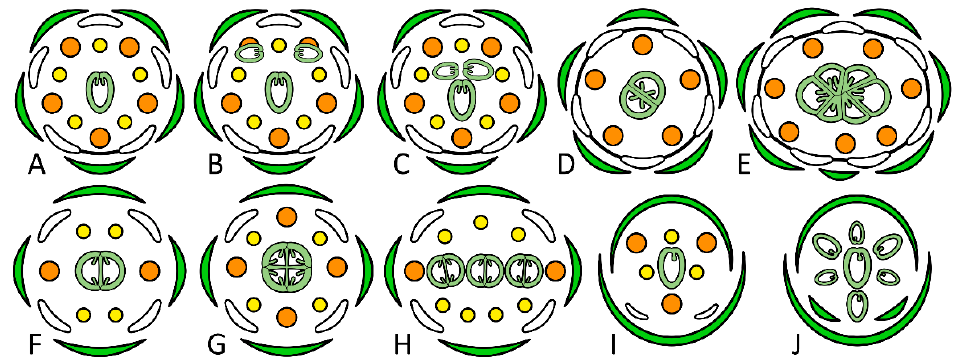
Figure 1. Floral diagrams illustrating normal and anomalous multicarpellate morphologies. ( A ) typical flower of most cultivated legumes, such as pea or bean; ( B ) mutant stamina pistilloida-1 of pea with the partial conversion of stamens into carpels; ( C ) Vuralia turcica with three carpels most probably emerging in successive mode; ( D ) wild-type flower of Solanum spp.; ( E ) flower of tomato mutants such as fasciated or locule number ; ( F ); wild-type flower of most Brassicaceae; ( G ) exemplary flower of clavata1 mutant of Arabidopsis thaliana ; ( H ) flower of the multi-silique mutant of Brassica napus ; ( I ) wild-type flower of rice; ( J ) flower of the stamenless1 mutant of rice with lodicules replaced with palea/lemma-like organs and stamens with carpels (simplified). The normal gynoecium of rice is represented as unicarpellate, which is debatable. Key: dark green color = sepal/palea/lemma; white color = petal/lodicule; orange color = outer stamen; yellow color = inner stamen; light green = carpel; line between organs = fusion (not shown in a calyx and an androecium).